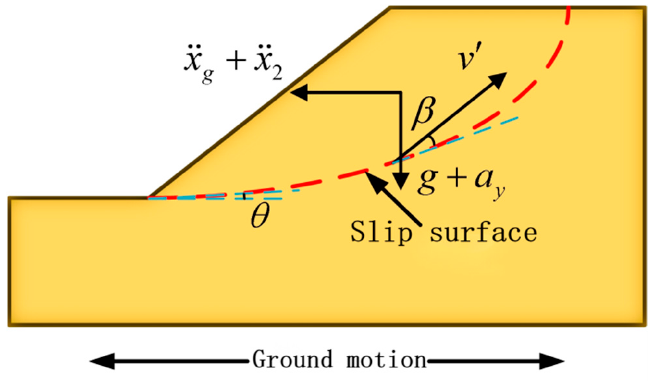
Figure 7. Calculation diagram of negative critical acceleration.